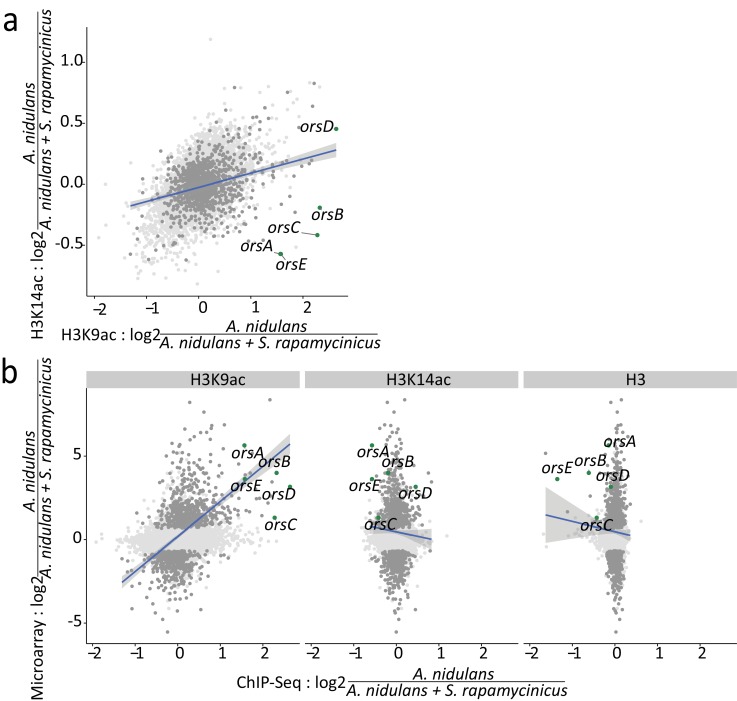
Relation between ChIP-seq and microarray data.The blue lines resemble the linear regression line based on the differentially expressed genes with an adjusted p-value of <0.1; the confidence interval shown in gray. (a) Log-fold changes (LFCs) for H3K14ac plotted against LFCs for H3K9ac. Dots depicted in dark gray and green mark differentially expressed genes and ors cluster genes, respectively. (b) Pairwise comparison of LFCs of H3, H3K14ac and H3K9ac data with microarray data obtained during co-cultivation of A. nidulans with S. rapamycinicus.